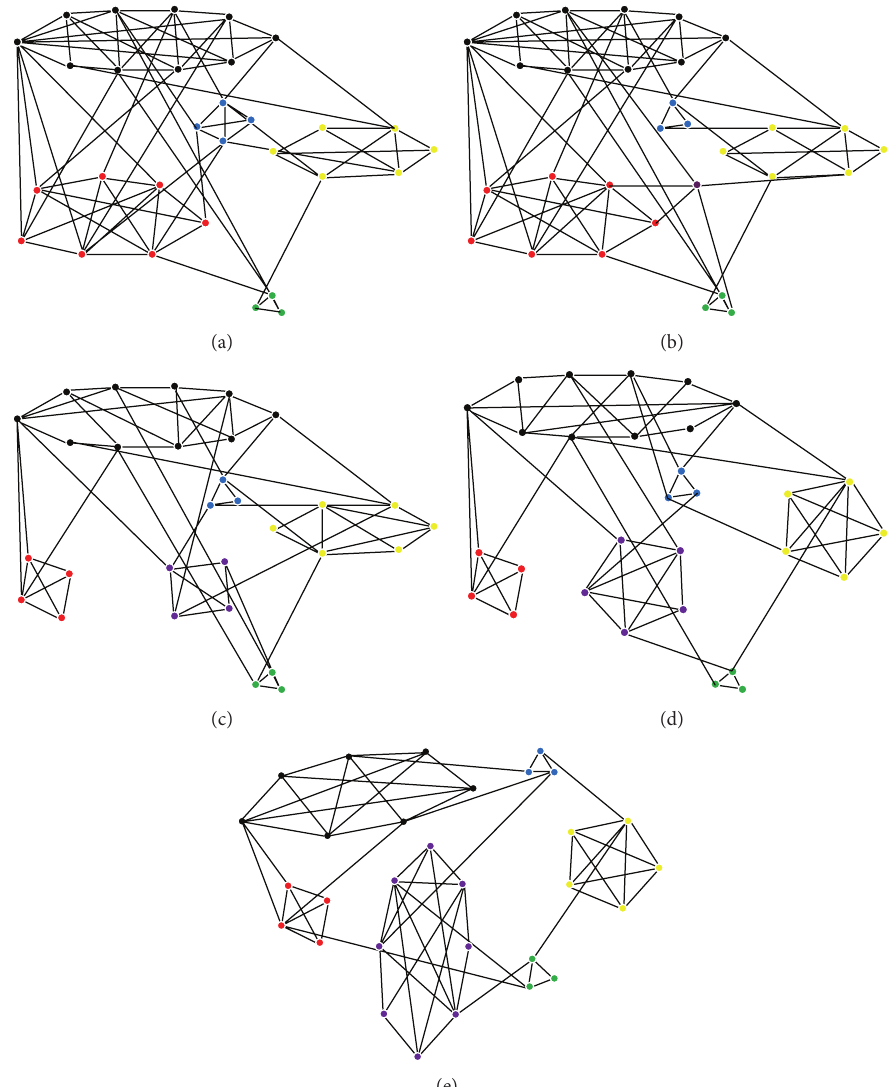
Figure 2: It is a visualization of change of networks’ structure in a predicted sequence from 𝑖Δ𝑡 to (𝑖 + 4)Δ𝑡 , which shows a simple derivation process. Different partitions are distinguished by different colors of